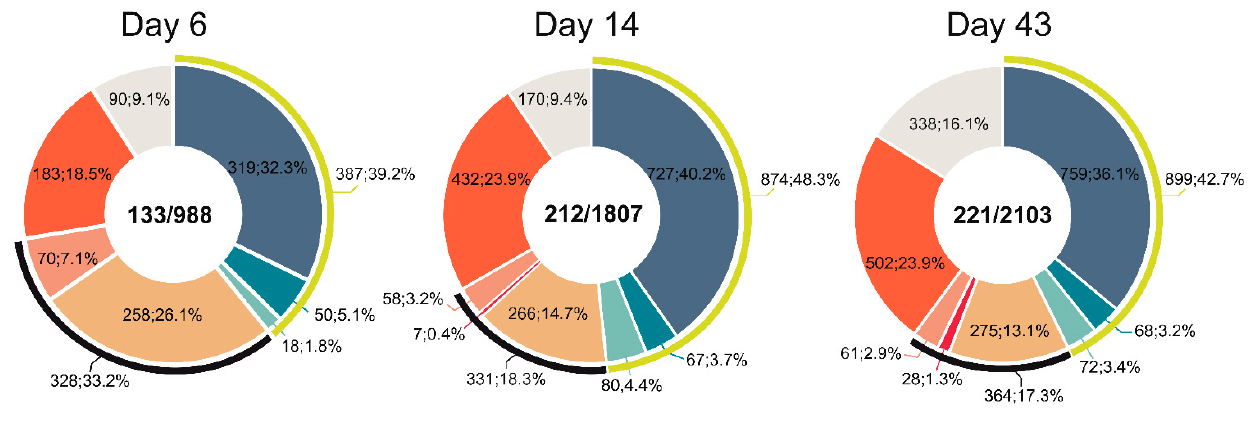
Figure 5. Abundance in PSM values (followed by the percentage) of the main protein types, indicated by color codes, in the exoproteome on wheat–straw cultures after 6, 14, and 43 days of incubation. The central numbers correspond to the number of secreted proteins (left) and their abundance in PSM values (right). Black and yellow arcs indicate oxidoreductases and CAZymes, respectively.